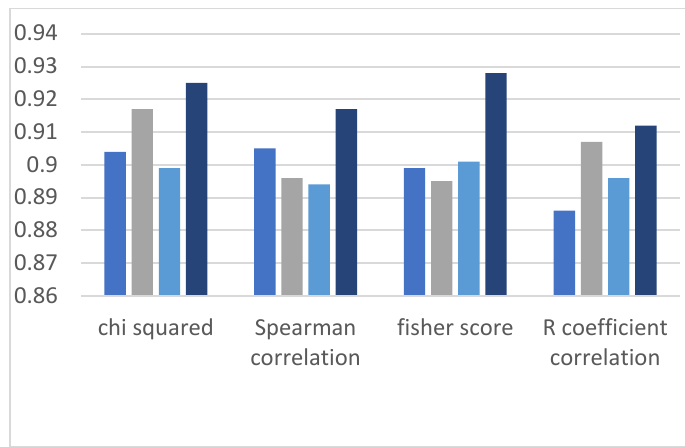
Figure 14. Recall using enhanced DT.